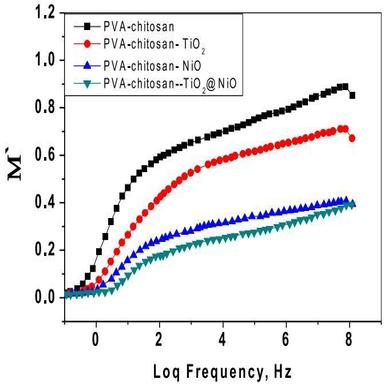
Variation in M″ with Log f for the PVA-chitosan–TiO2, PVA-chitosan–NiO, and PVA-chitosan– TiO2@ NiO films.